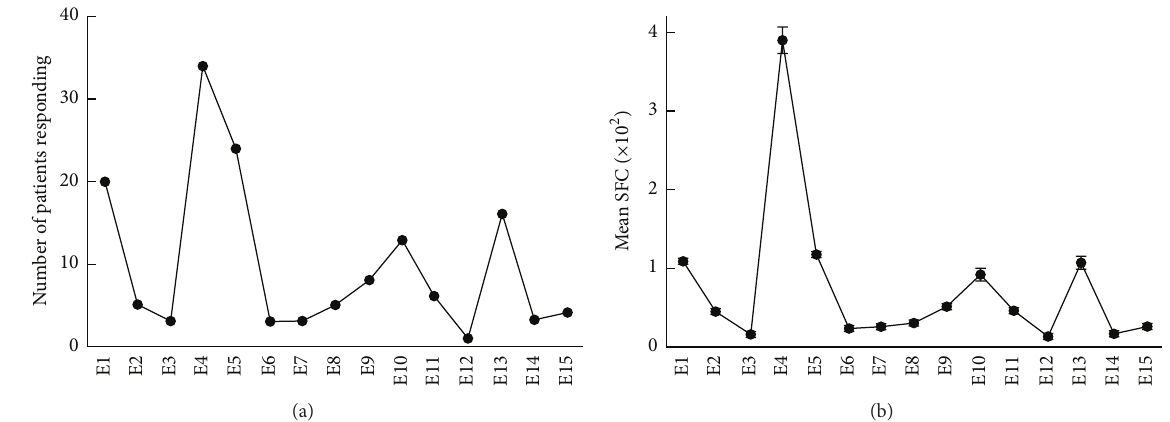
Figure 2: Antigenic regions from ESAT-6. PBMCs were incubated with overlapping peptides from ESAT-6 (E1–E15), and the number of IFN- 𝛾 producing cells was measured using the ELISPOT assay. Shown are numbers of donors who responded (a) and the mean ( ± SE) number of SFCs (spot forming cells)/10 7 PBMCs in response to each peptide (b).